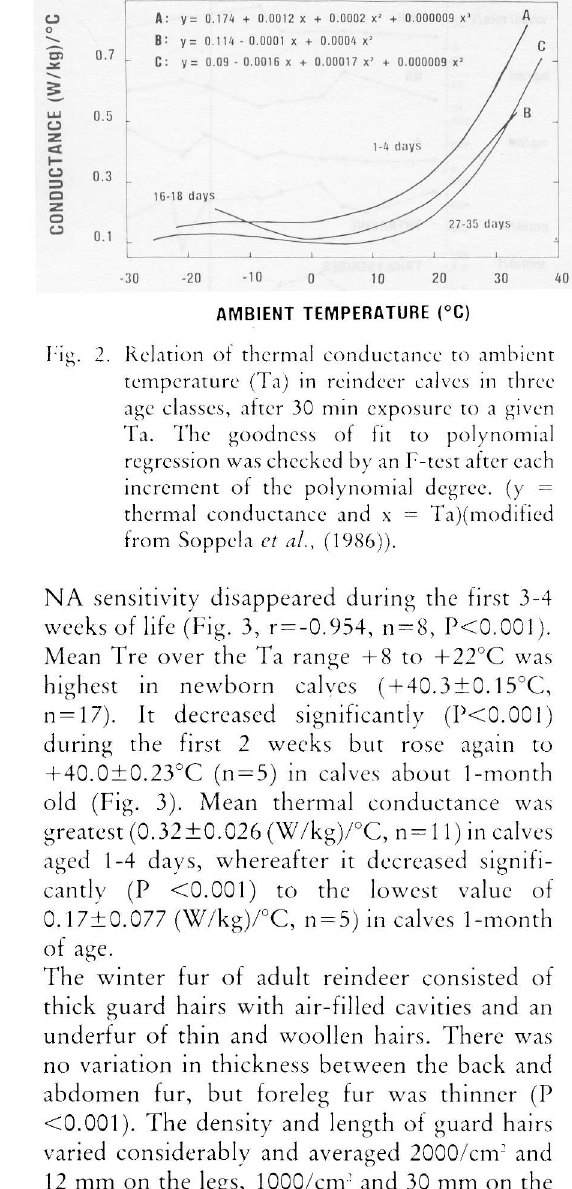
Fig. 3. A. Metabolic response to subcutaneous injection of noradrenaline (0.2 or 0.4 mg/kg) in 1 to 27 days old reindeer calves at 0°C. B . C. Changes in rectal temperature (Tre) and thermal conductance with age in 1 to 35 days old calves at 4-8-22°C. (yl = maximum change in oxygen consumption, v2 = Tre, y3 = thermal conductance and x = age in days)(modified from Soppela et al.,